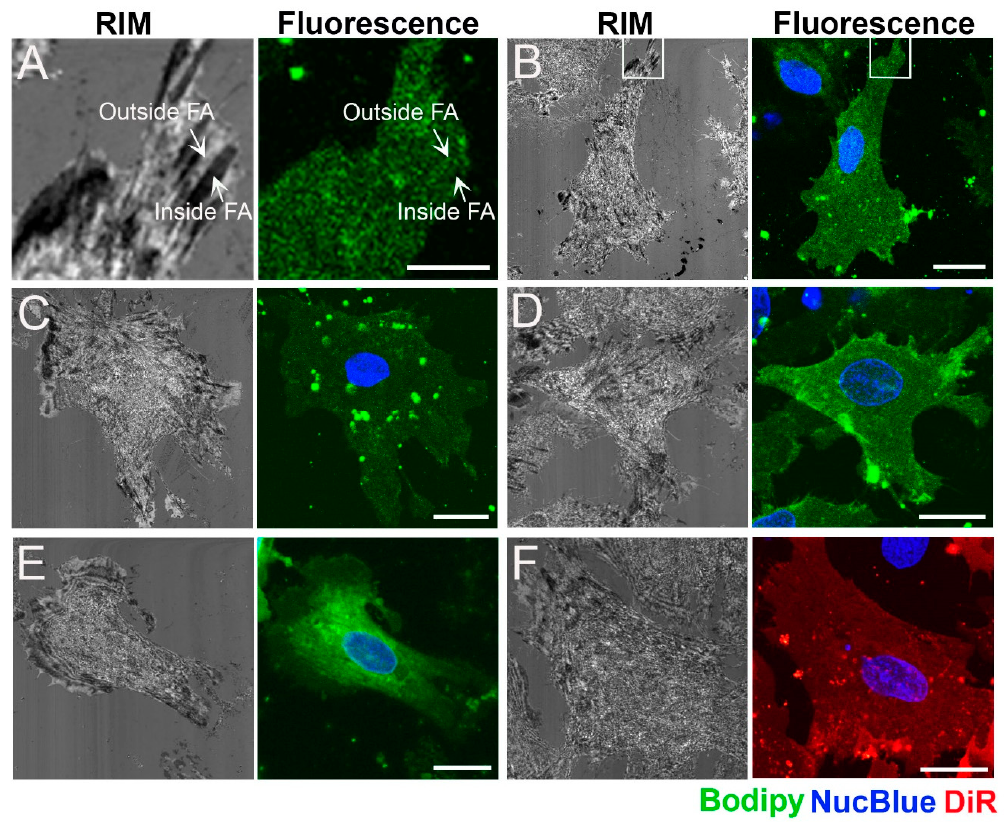
Figure 2. Primary cardiac fibroblasts with maturated focal adhesion sides on the lamellipodia. ( A ) Localizations of FAs by RIM on a cardiac fibroblast. FAs appear as low-intensity, elongated spots distributed mainly throughout the lamellipodium (inside FA arrow). In contrast, membrane regions without close proximity to the extracellular matrix appeared as brighter areas in RIM images (outside FA arrow). Scale bar = 5 µm. Fluorescent and RIM images of cardiac fibroblasts after incorporation of see materials and methods. Lipid distributions, nucleus staining, and DiR localization are shown in green, blue, and red, respectively, while RIM images are presented in gray scale. Scale bars, 20 µm.